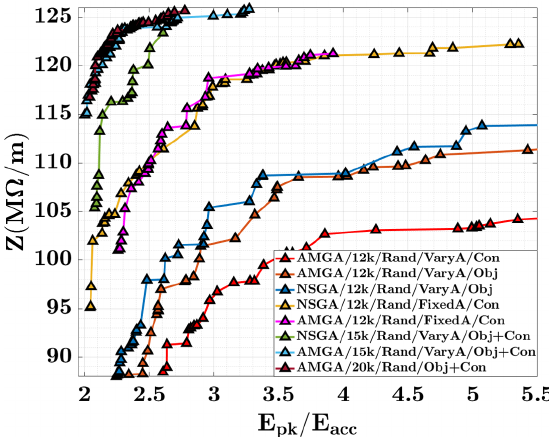
FIG. 6. Algorithm and constraint handling method comparison for the traveling wave (TW) X-band structure, showing the Z vs E =E Pareto fronts. The legend follows the format algorithm/ pk acc number of individual evaluations/initialization mode/fixed or varying aperture radius/constraint handling